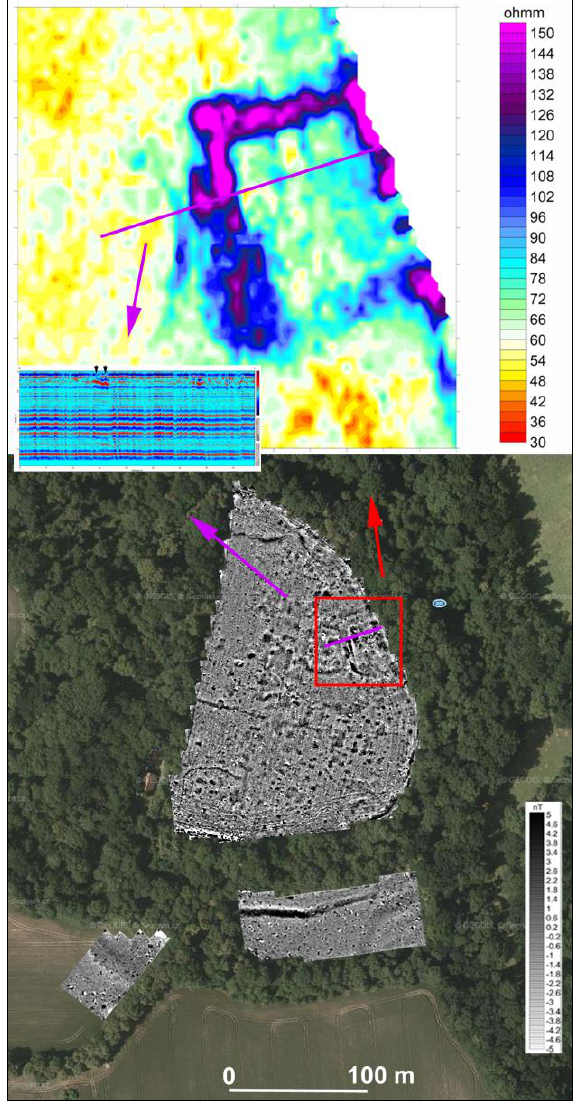
Figure 1. Prague-Vinoř, district Prague 9. Combination of aerial photograph of the site from 2010 and results of magnetometric, geoelectric resistivity survey and GPR measurement inside of hillfort (source of aerial photo: www.kontaminace.cenia.cz; total surveyed area - magnetometry: approx. 3.6 ha; detail of geoelectric resistivity measurement: approx. 0.3 ha; geophysical survey: Křivánek